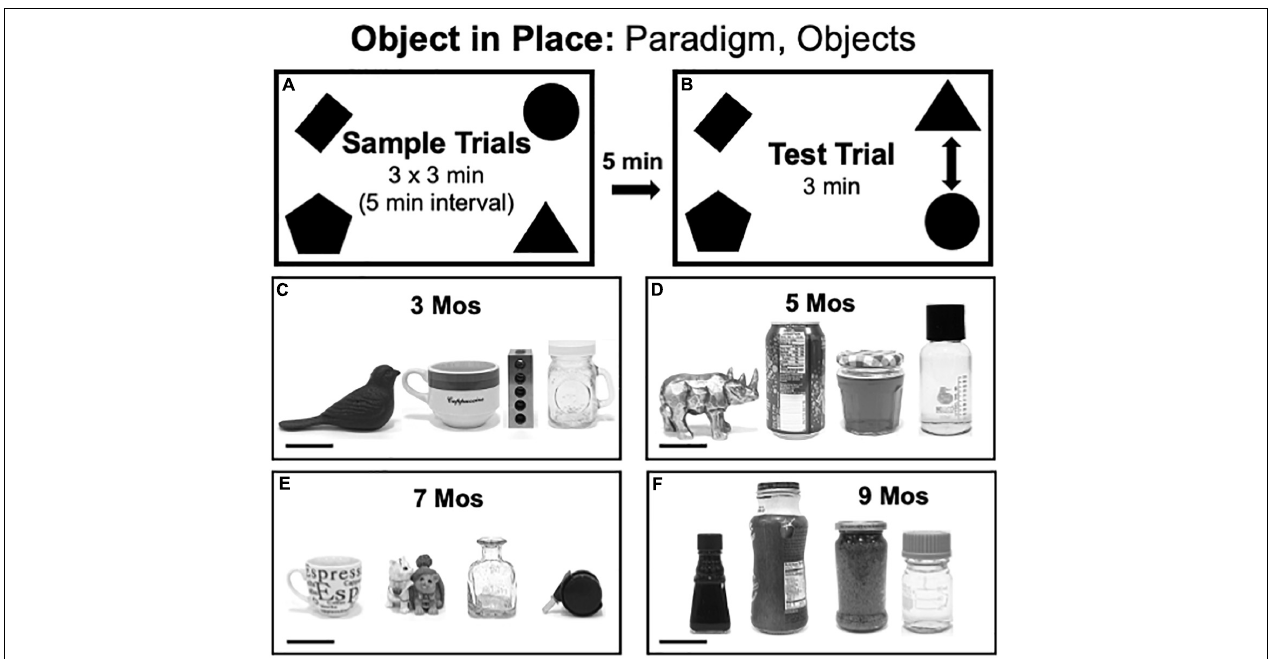
FIGURE 4 | (A,B) Schematic diagrams showing trial structure for the Object in Place paradigm. (C–F) Black and white photographs showing the four distinct items used as sample objects for testing at each of the four ages evaluated [3, 5, 7, and 9 months (mos) of age]. From left to right, the objects used in testing at 3 mos of age (C) were made of cast iron, ceramic, steel or glass. The objects used in testing at 5 mos of age (D) were made of glazed ceramic, aluminum, contoured glass or smooth glass (left to right). The objects used in testing at 7 mos of age (E) were made of ceramic, molded plastic, glass, or smooth plastic with metal. The objects used in testing at 9 mos of age (F) were all made of glass. Scale bars = 50